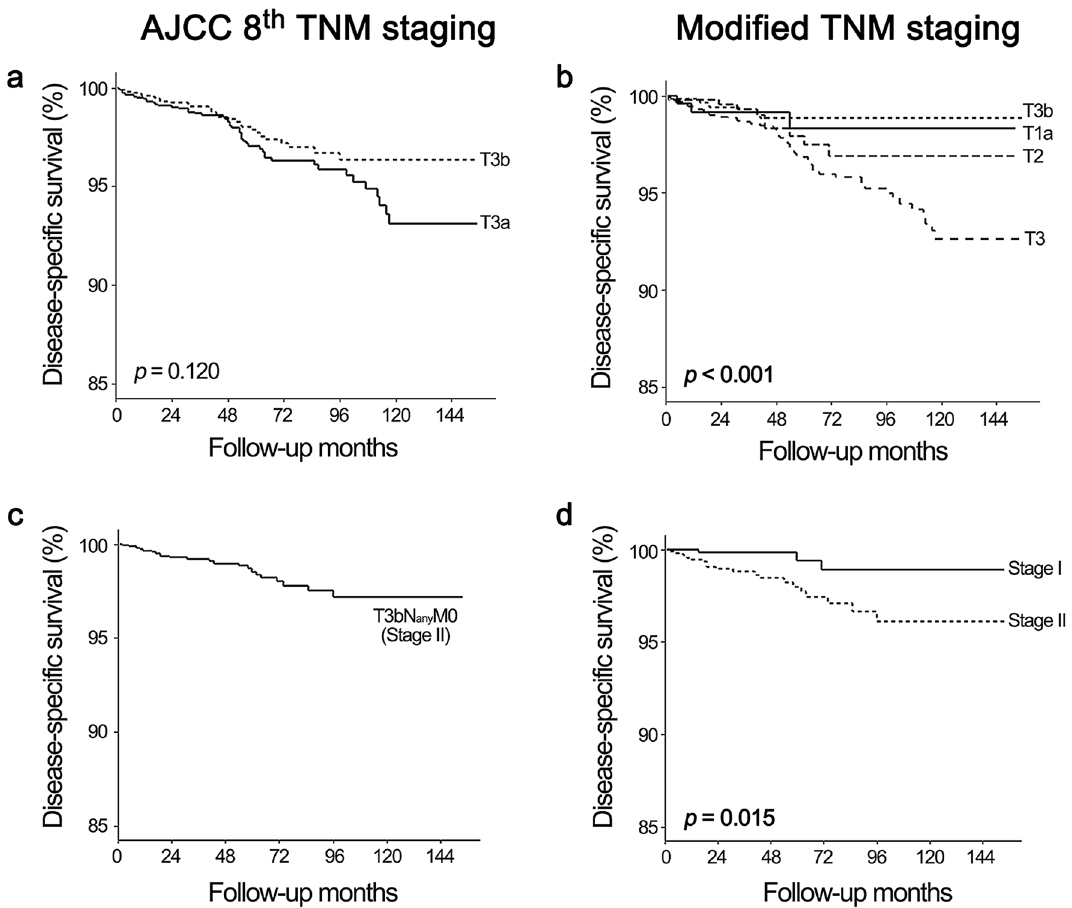
of the disease-specific survival (DSS) between the T3a and T3b stages according to the AJCC 8th TNM staging schema ( a ) and the modified TNM staging schema ( b ). Reallocation of the T3a and T3b stages according to